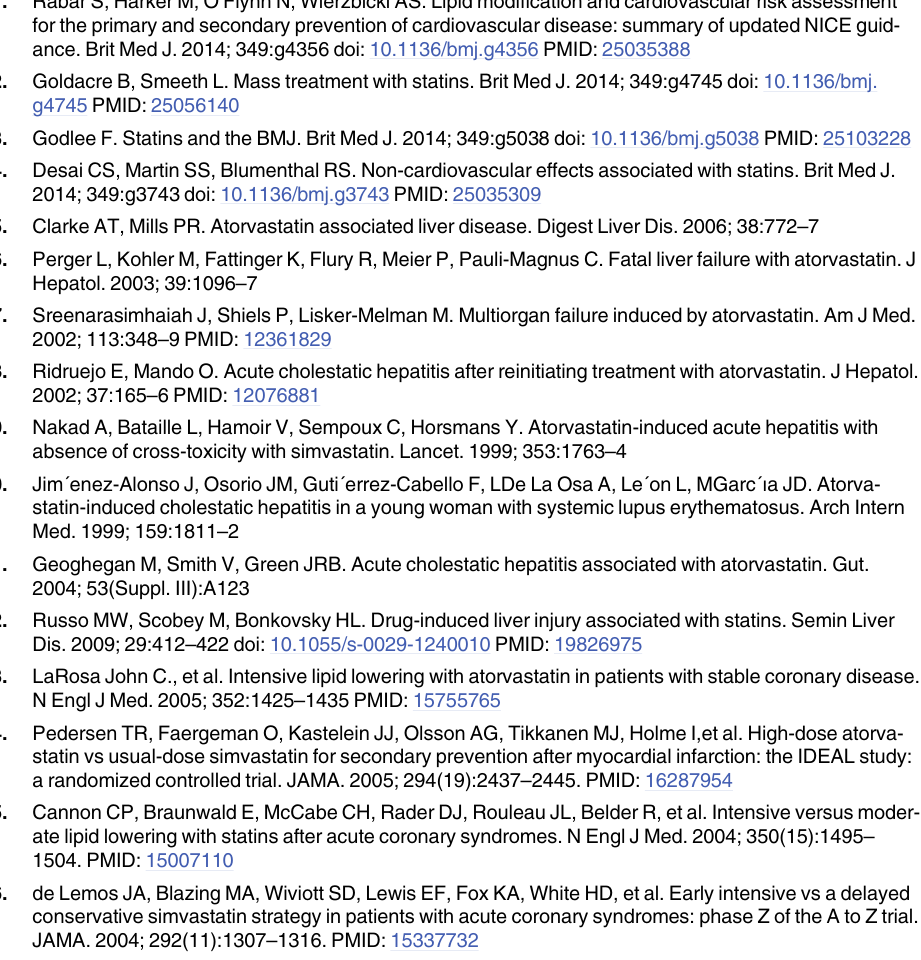
S3 Table. Hazard ratio [HR] estimates [95% CI] for significant lab events associated with statin-dose combinations during the first 6 months therapy, relative to low dose simva- statin. Only patients with a history of MI, CHD, CVD or PVD were included.